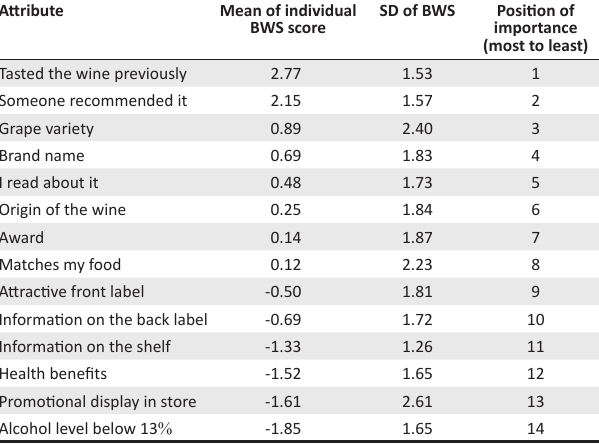
TABLE 2: Summary of the best–worst scaling scores of wine attributes ( N =